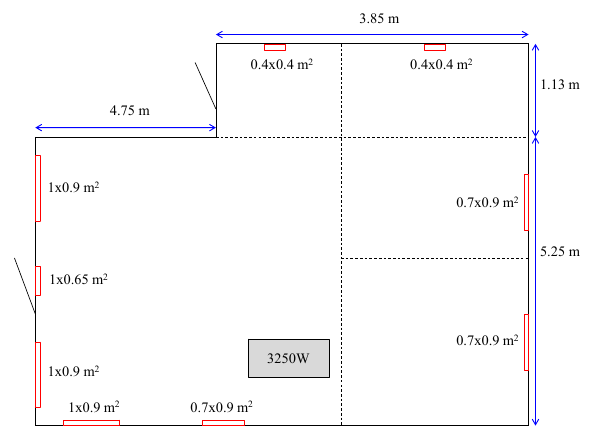
Figure 11: Structure of the simulated builing